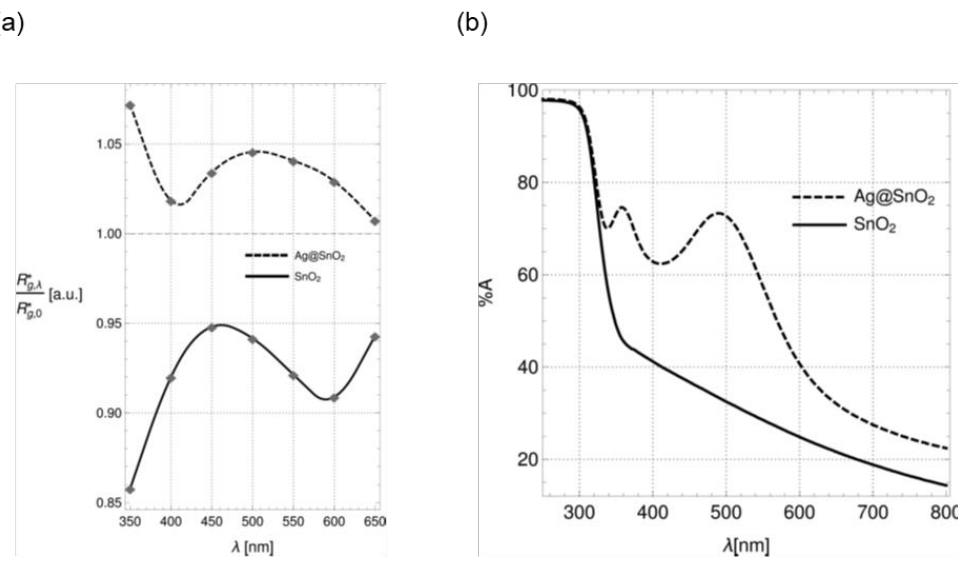
Figure 14. ( a ) Enhancement factor as a function of wavelength. A value > 1 corresponds to an actual light-induced enhancement, whereas a value < 1 means a light-induced quenching. ( b ) UV − vis spectra of bare and Ag-decorated SnO 2 nanowires. Reproduced with permission [98].